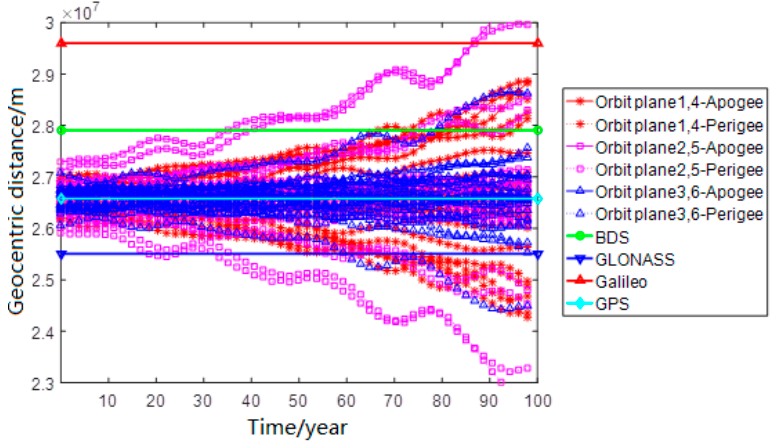
Figure 7. Orbital variations of GPS operational satellites over 100 years.